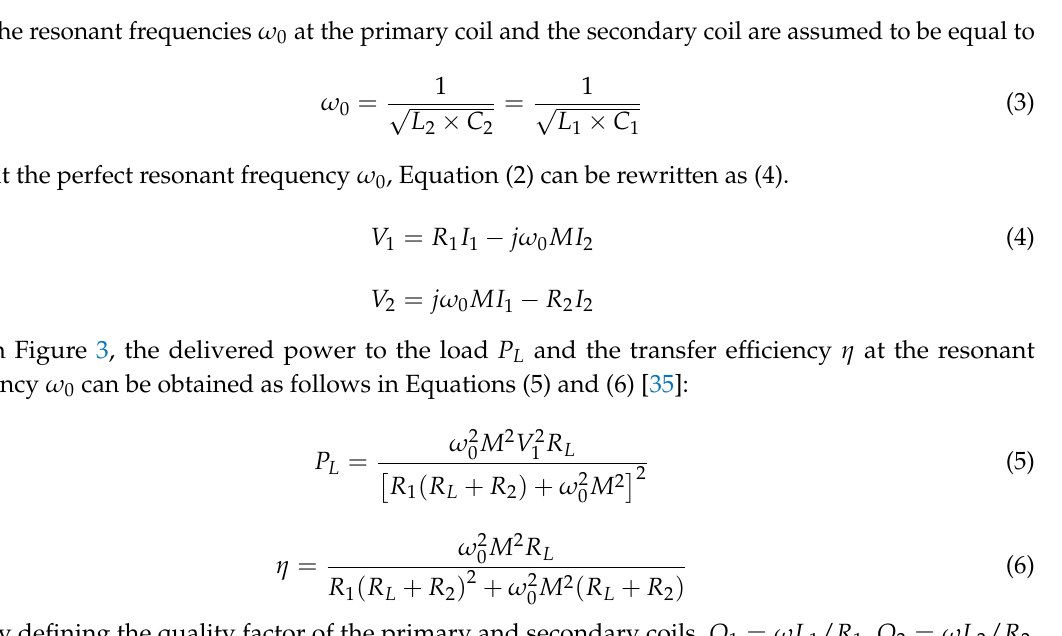
Figure 3. Equivalent circuit model for SS topology.